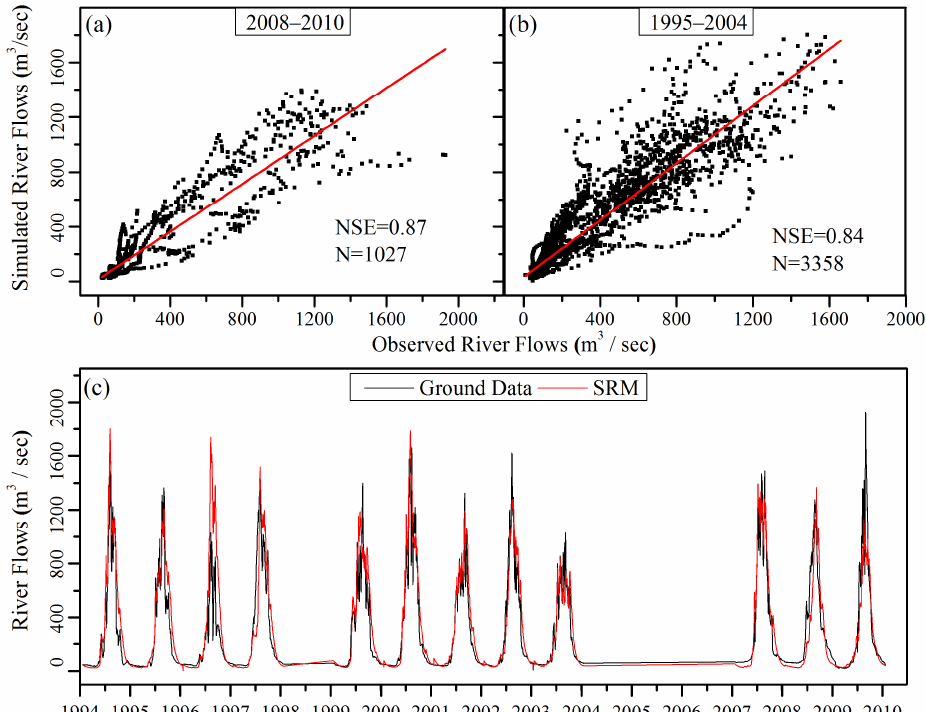
Figure 9. ( a ) Simulated vs. recorded flows during calibration period (2008–2010). ( b ) Simulated flows versus observed flows during the validation period (1995–2004). ( c ) Comparison between observed and simulated flows in the Hunza River Basin during 1995 and 2010.